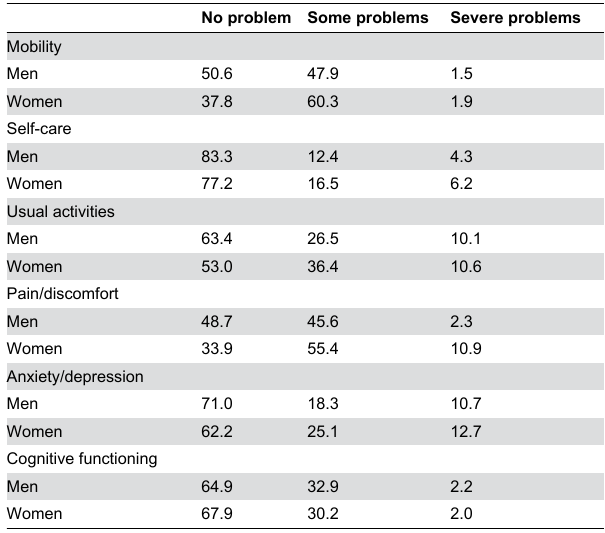
Table 3. Percentage of older persons reporting no, some or severe problems on the EQ-5D+C quality of life scale by sex, The Older Persons and Informal Caregivers Minimal DataSet, Netherlands,